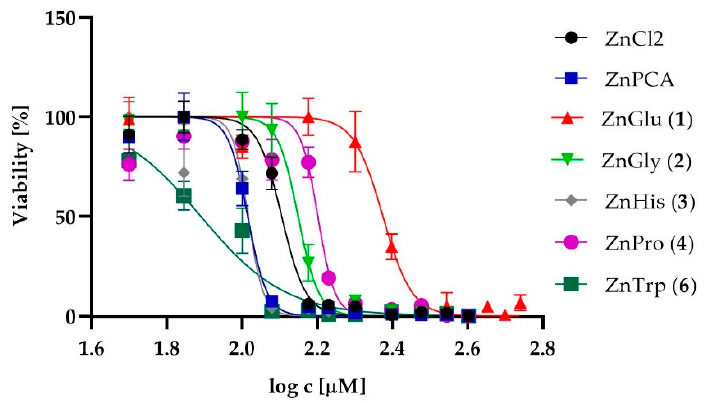
Figure 2. The normalized dose-response curves for the analyzed zinc complexes and reference compounds against keratinocytes